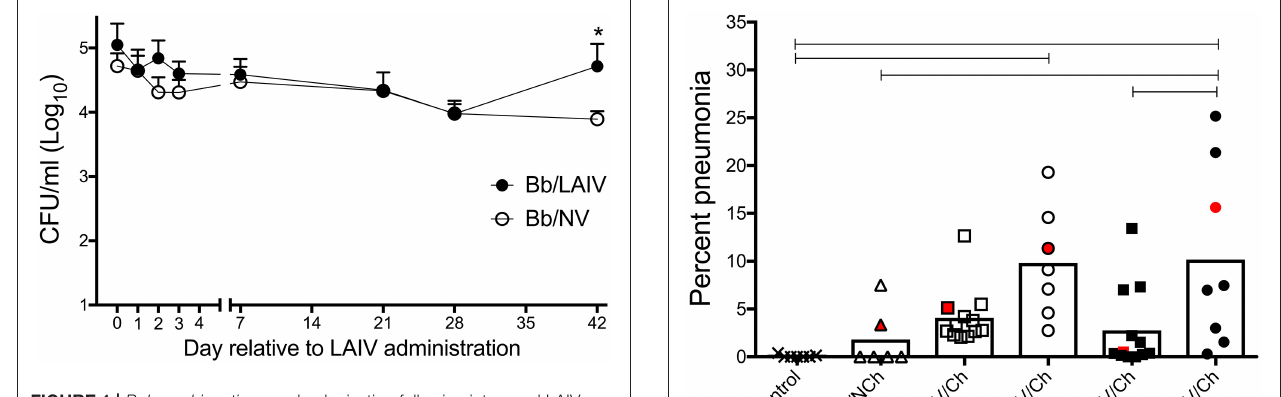
FIGURE 1 | B. bronchiseptica nasal colonization following intranasal LAIV administration. To determine if B. bronchiseptica (Bb) nasal colonization was impacted by LAIV administration, Bb CFU’s were enumerated at indicated day’s post-LAIV administration. Pigs were intranasally inoculated with Bb on day − 7 (not shown) and LAIV on days 0 and 21. In accordance with Table 1 , pigs in groups 4 and 5 were included in the Bb/NV group ( n = 13) and group 6 pigs were used for Bb/LAIV group ( n = 8). Data is reported as the number of CFU per ml in nasal swabs (days 0–3) and nasal wash (days 7, 21, 28, and 42). Significant differences ( p < 0.05) in Bb CFU are noted with an asterisk (*).